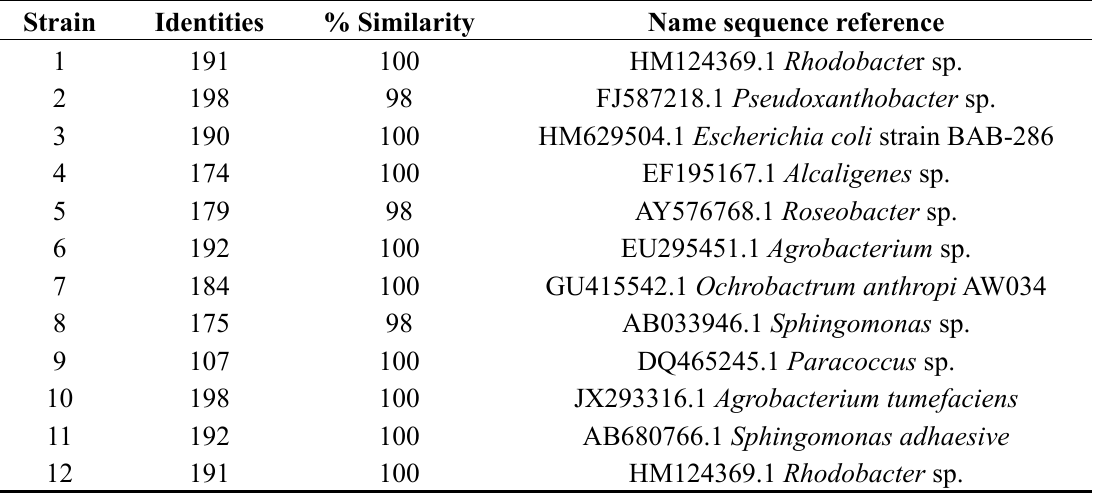
Table 2. Taxonomic analysis of struvite-forming bacteria from the data bank